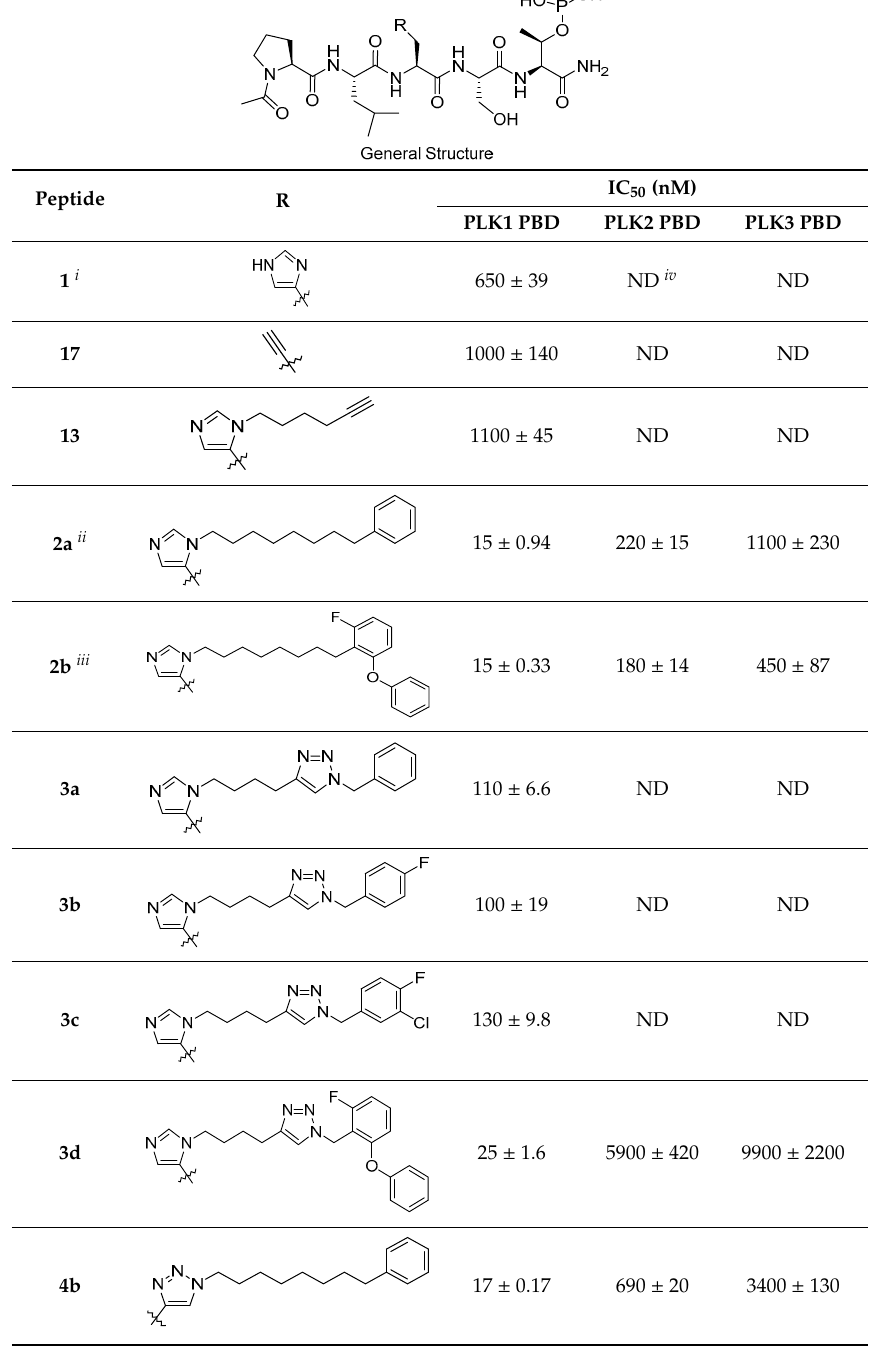
Table 1. Inhibitory potencies of peptides containing different linkers using a fluorescence polarization (FP) assay. Polo-like kinase (Plk), polo-box domain (PBD).